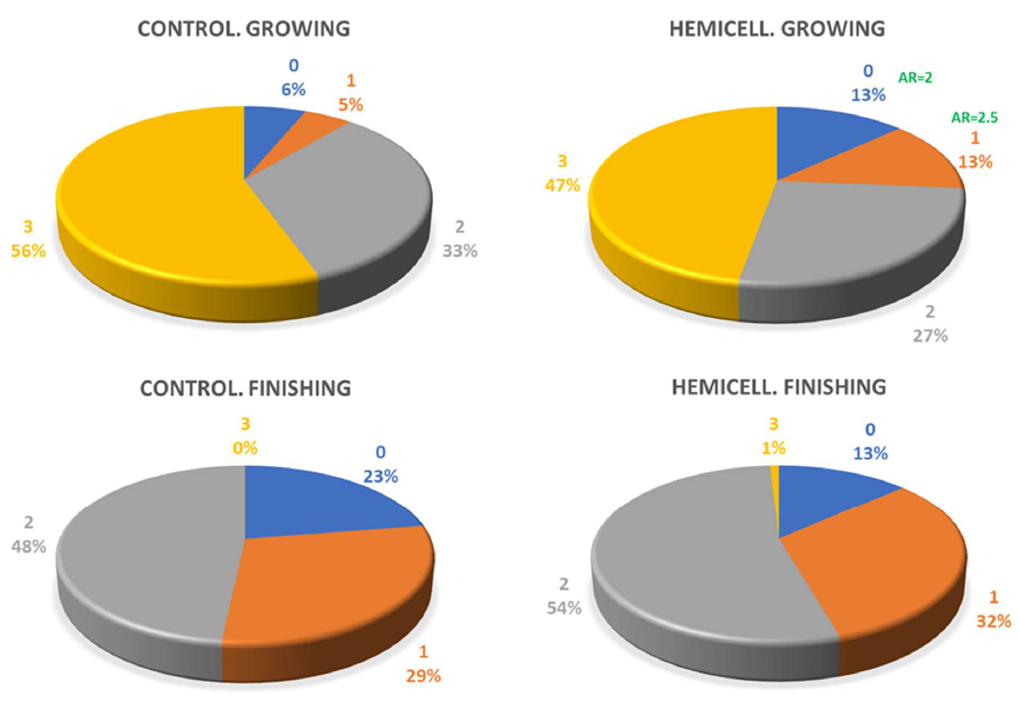
Figure 3. Frequencies observed for fecal consistency score during growing and finishing. The values indicate frequency of each score and AR= adjusted residues in the frequency analysis by contingency tables. Only those frequencies showing AR differed significantly from expected frequency. The frequency difference in the Hemicell-growing group had a significance of p = 0.008.